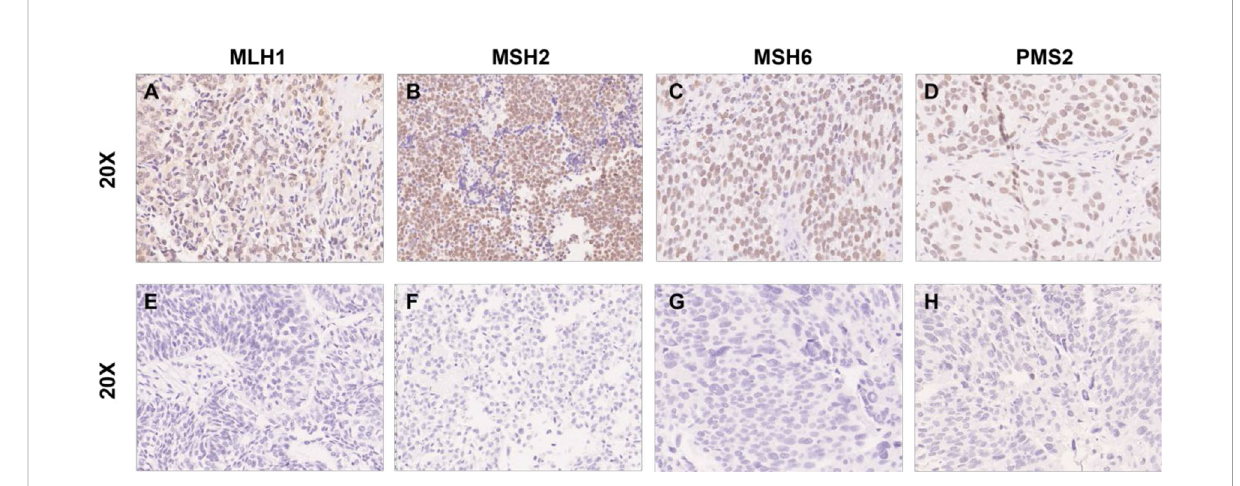
FIGURE 1 Representative image of negative/positive IHC results of MMR